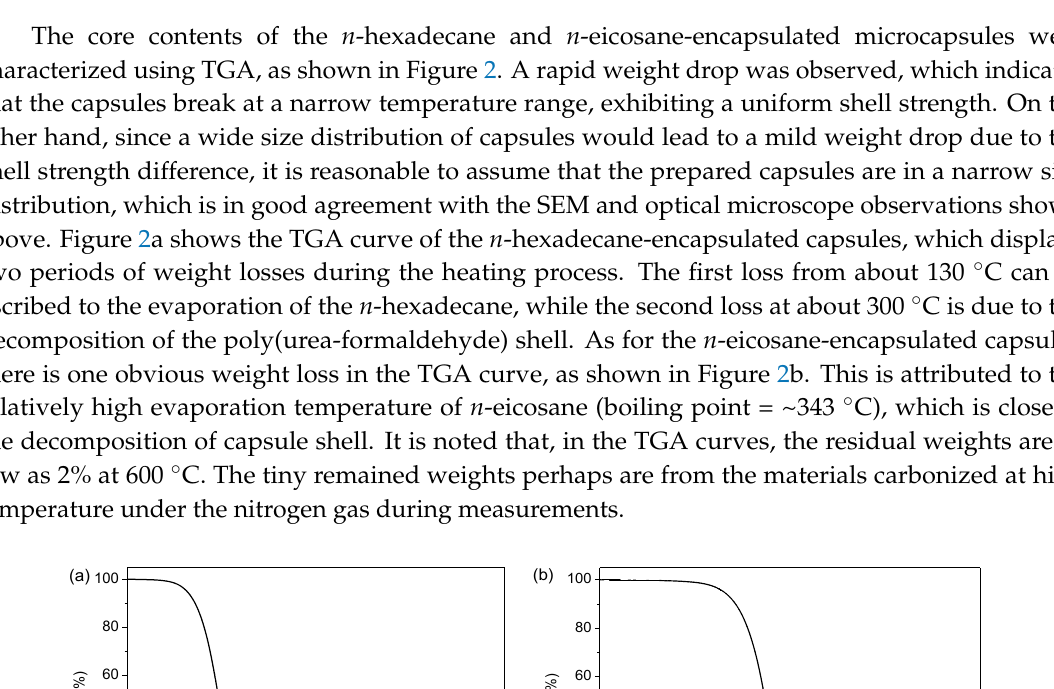
Figure 1. SEM images of the ( a , b ) n -hexadecane- and ( c , d ) n -eicosane-encapsulated microcapsules. TEM images of ( e , f ) n -hexadecane- and ( g , h ) n -eicosane-encapsulated capsules. The core-shell structure is marked in ( f ).